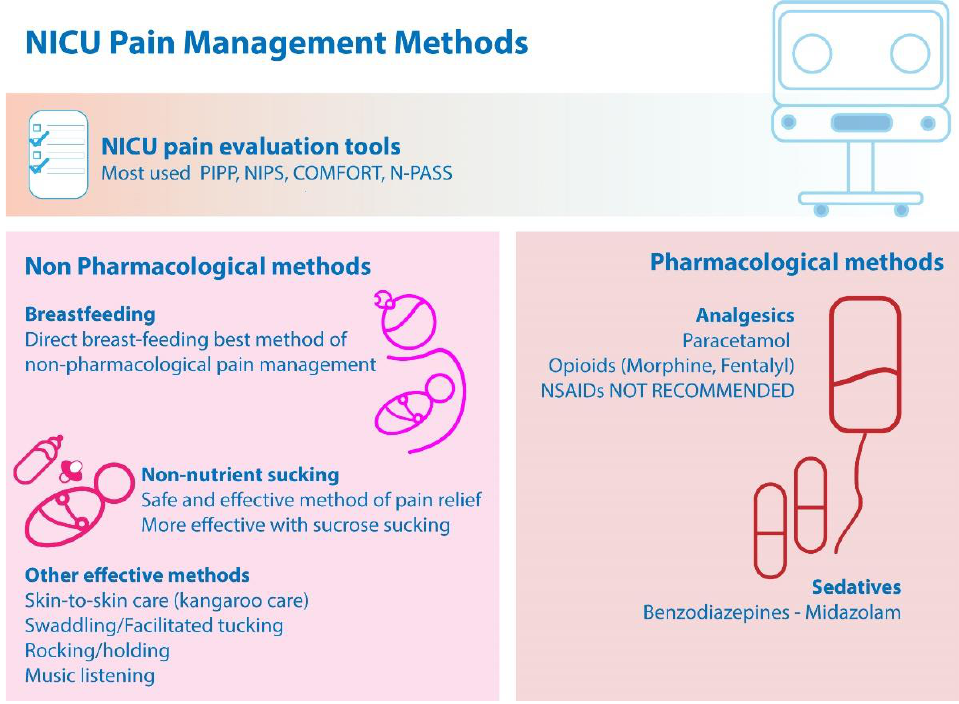
Figure 1. Main findings on NICU pain management methods.